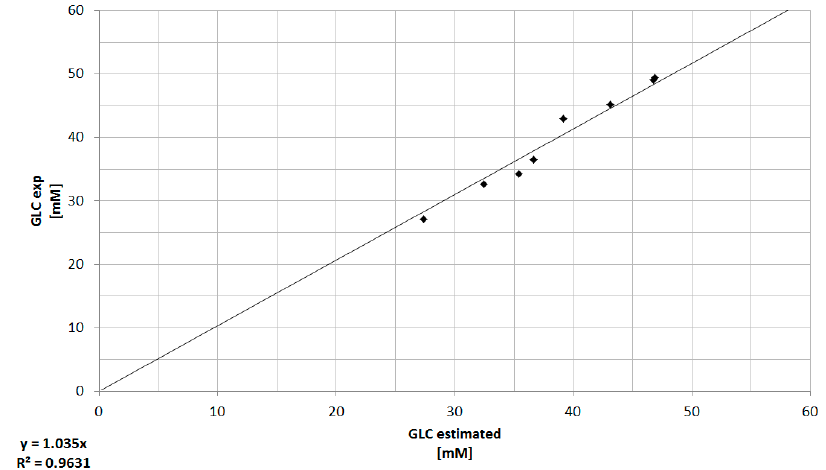
Figure 11. Comparison between offline measurements (exp) and model-based prediction of the glucose concentration. The deviation represents the offline double determination of the glucose concentration. The coefficient of determination for this relation is ≥ 0.96.